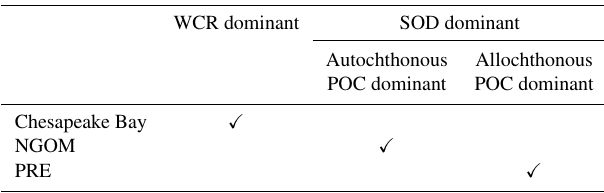
Table 3. A summary of characteristics of hypoxia among three sys- tems (i.e. Chesapeake Bay, northern Gulf of Mexico, and PRE). WCR represents the water column respiration, which is the sum of respiration, nitrification, and